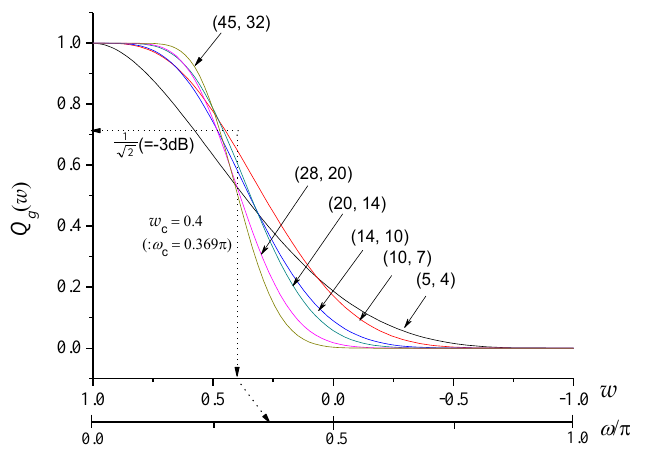
Figure 1. Maximally-flat (MAXFLAT) finite impulse response (FIR) filters: Q g ( w ) with various N for w c = 0.4 .